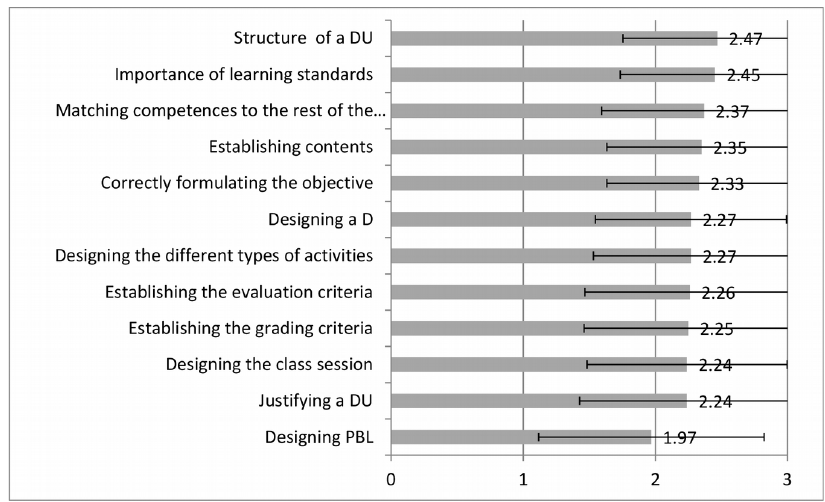
Figure 2. Usefulness of the training received (scale of 0 to 3)